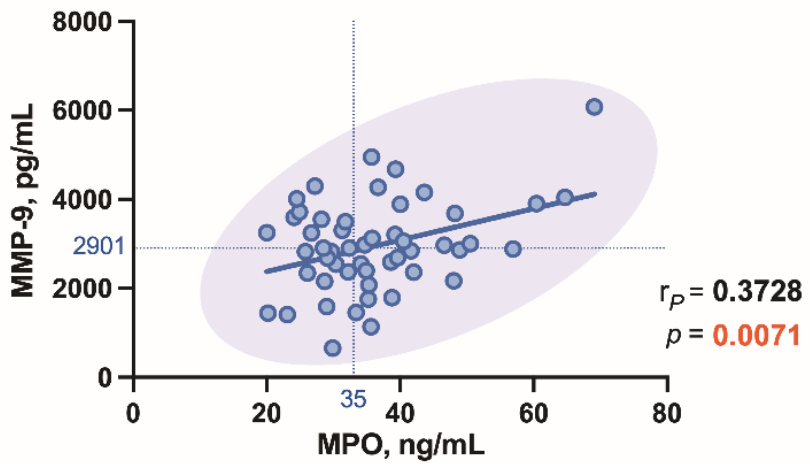
Figure 8. Correlation between MPO and MMP-9 levels in the aortic valve stenosis patients.